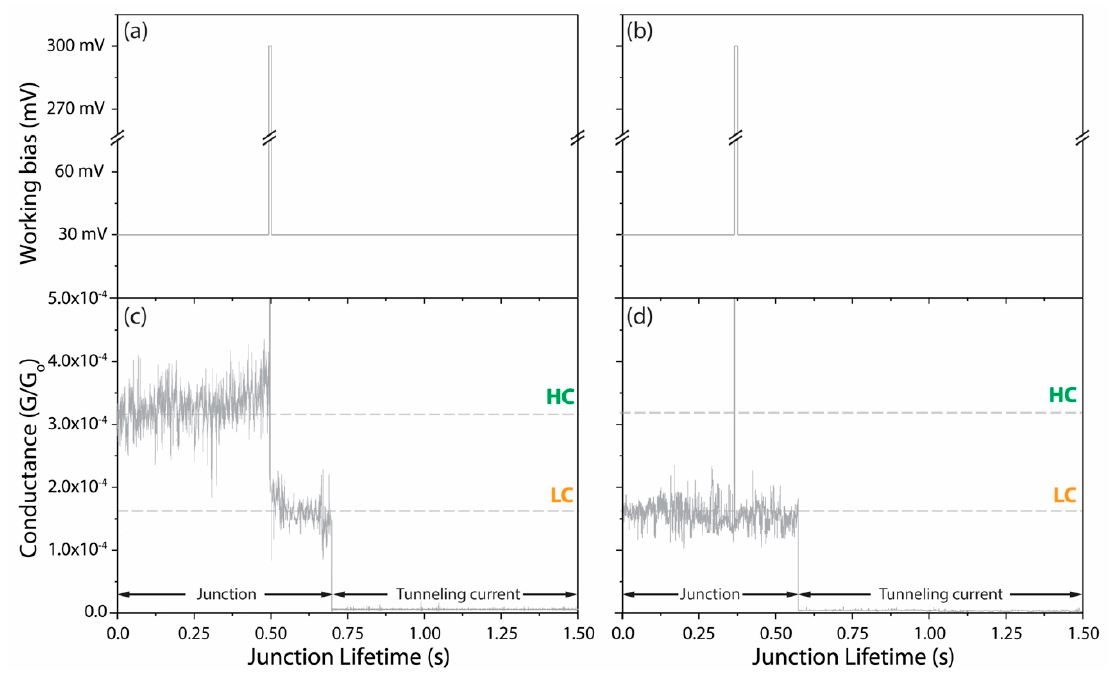
Figure A1. ( a , c ) V bias versus time traces indicating the 10 ms short voltage pulse of 300 mV. ( b , d ) Conductance versus time traces corresponding to the voltage schemes depicted in ( a , c ) at a fixed inter-electrode distance of ca. 3 to 3.5 nm.